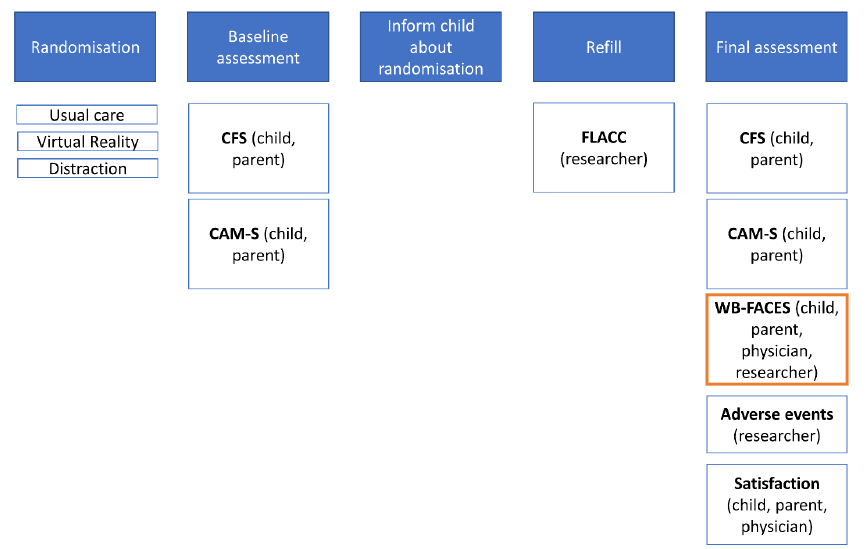
Figure 1. Schematic overview of the study outcome measurements. The primary outcome measure is indicated in orange.